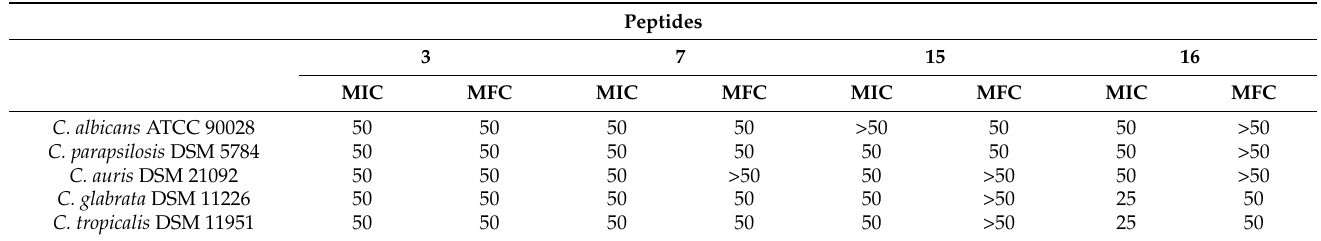
Table 2. Minimum inhibitory concentration (MIC, µ M) and minimal fungicidal concentration (MFC, µ M) of selected peptides against all Candida